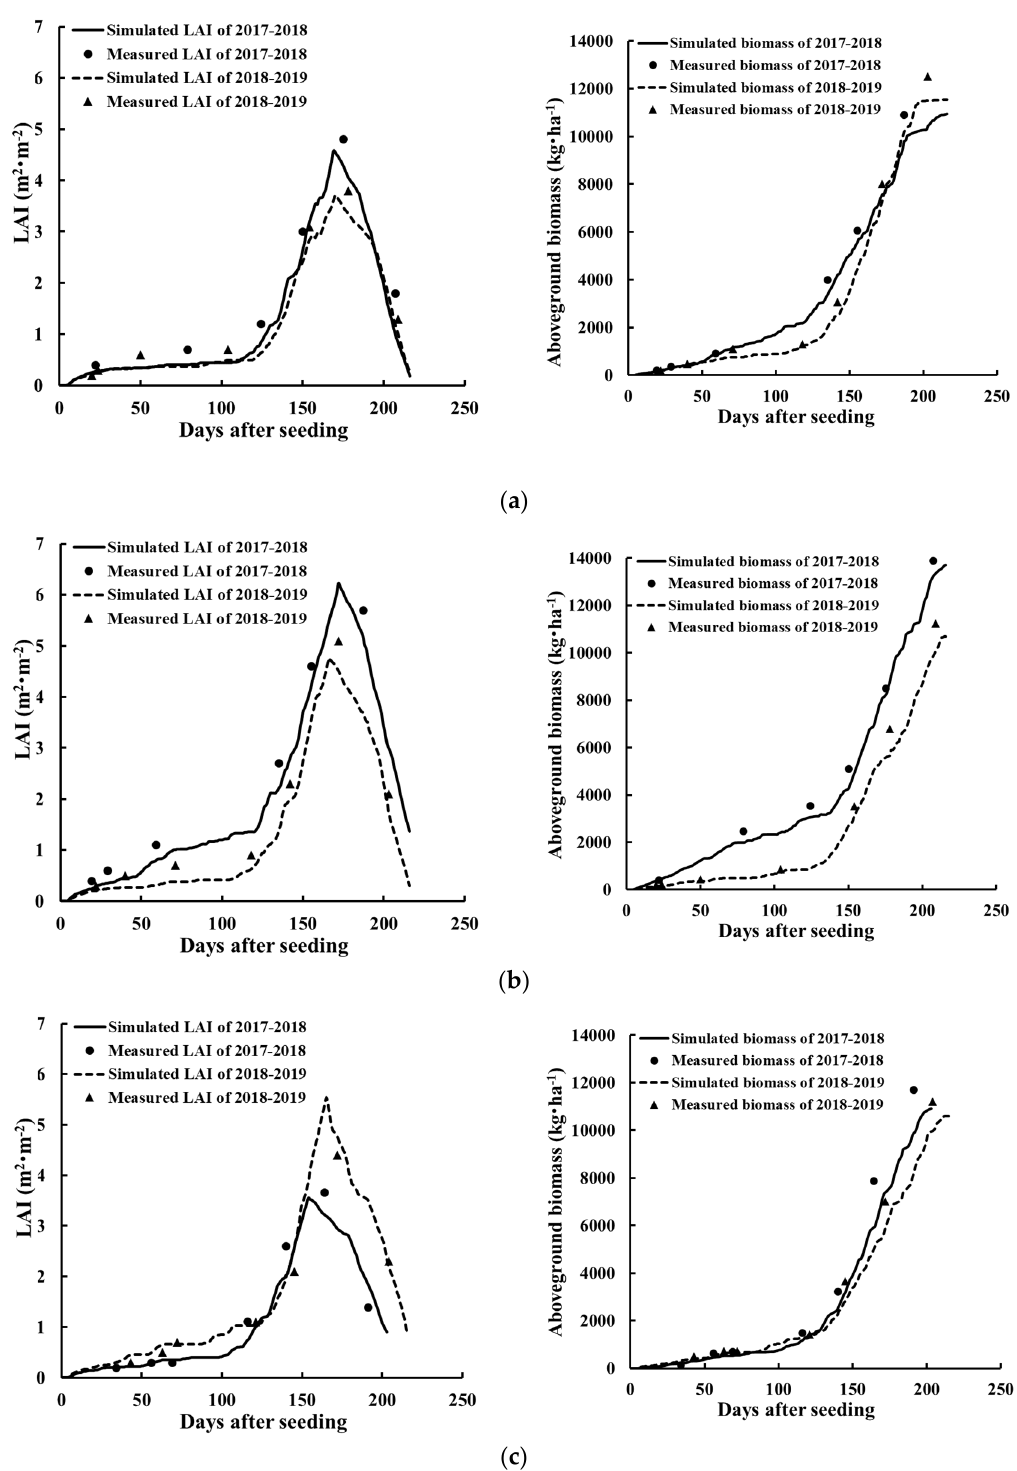
Figure 8. Comparisons between the simulated trajectories and field measurements for the LAI and aboveground biomass at the (a) Zhengzhou, (b) Huangfan district and (c) Xinyang stations, respectively.